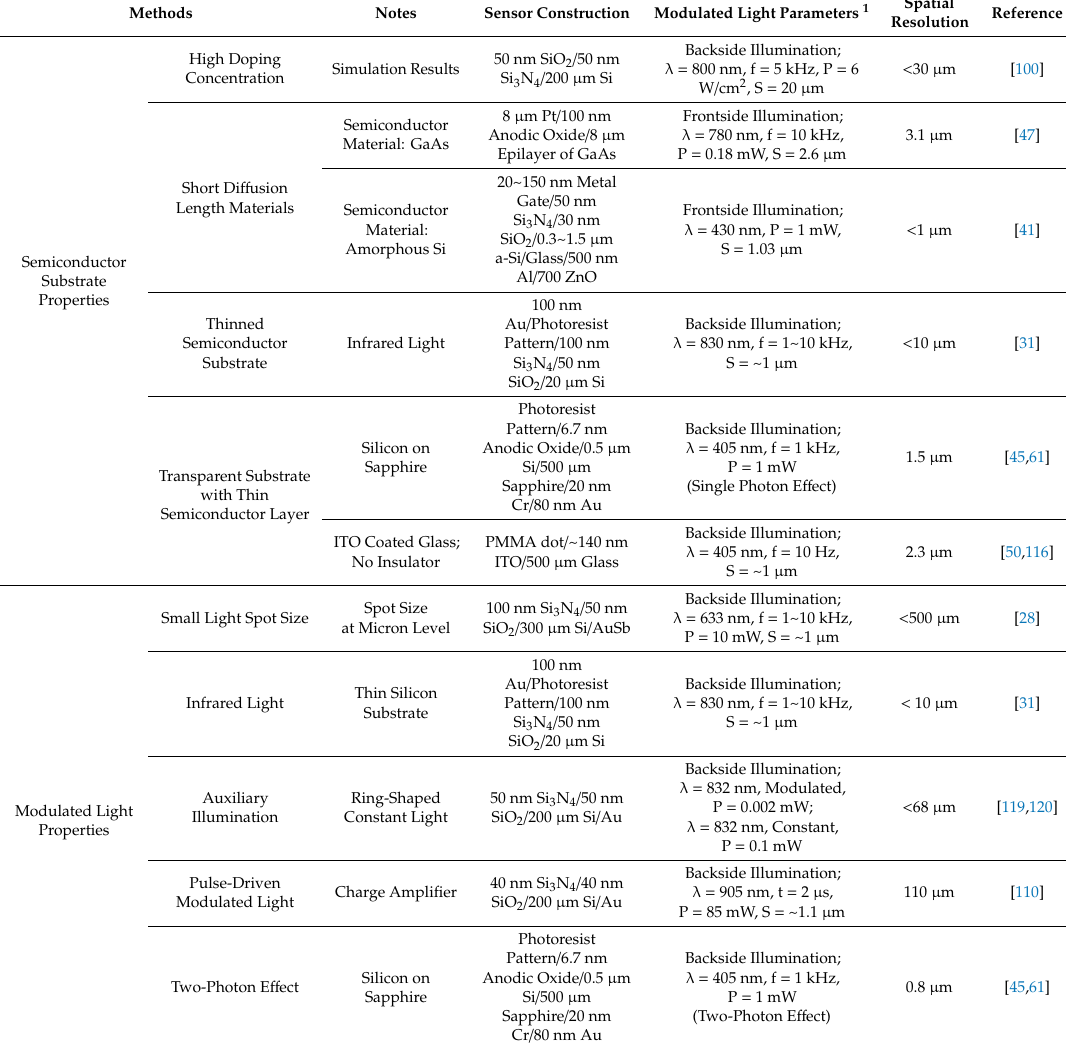
Table 2. Technical information about improving the spatial resolution of